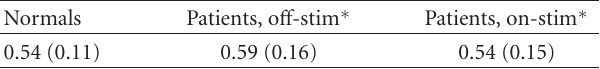
Table 5: Mean (and S.D.) vowel fraction by group.